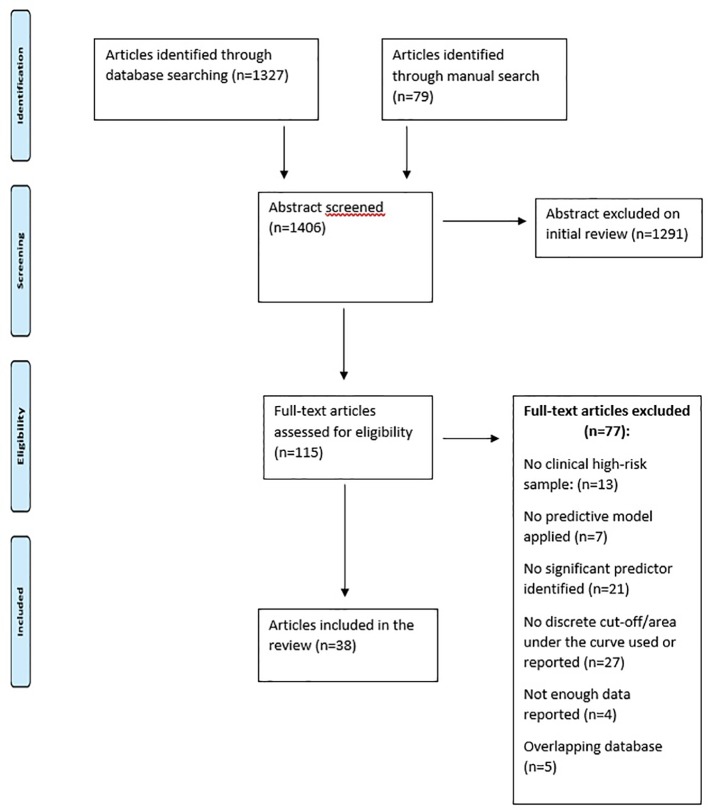
PRISMA flow chart.